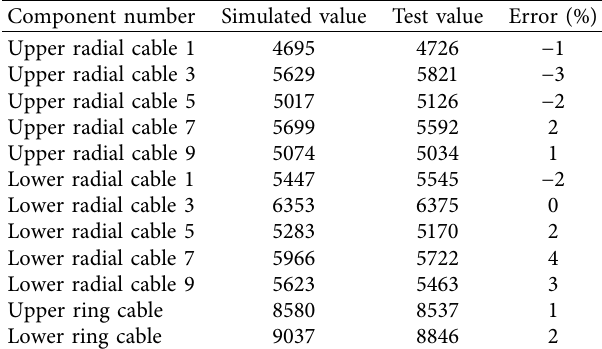
Figure 7: The BIM model of structure. Table 1: Comparison of cable force